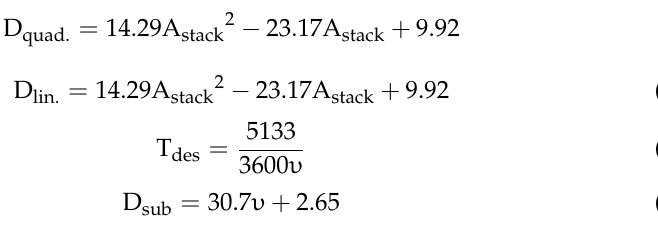
Figure 4. Simulink block diagram model.